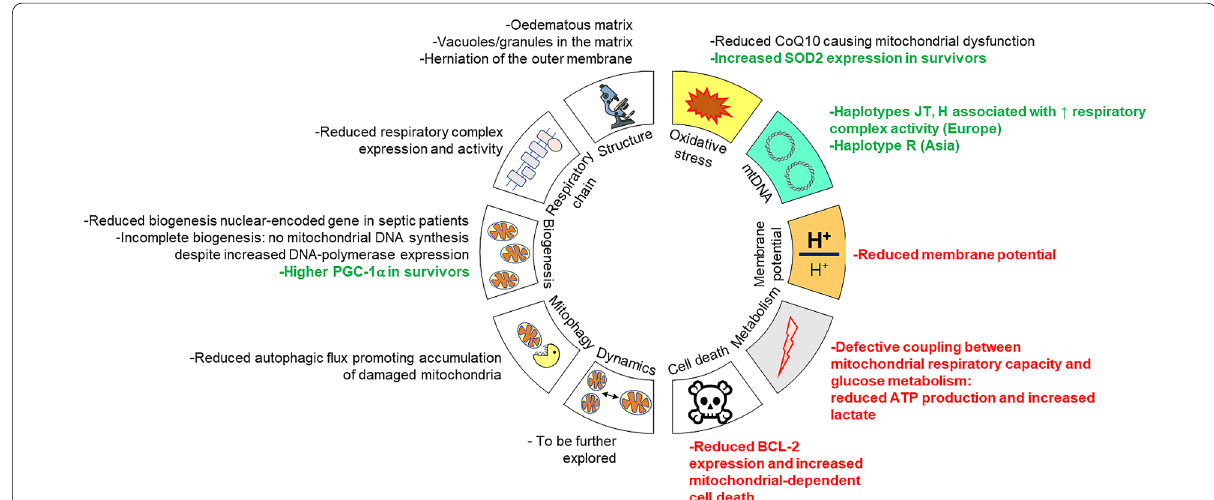
Fig. 4 Hallmarks of mitochondrial changes observed during human sepsis and septic shock. Bold red and green fonts refer to the association with increased mortality or survival, respectively. In the other cases, no correlations have been made. ATP adenosine triphosphate, BCL2 B-cell lymphoma-2, CoQ10 coenzyme Q10, DNA desoxyribonucleic acid, PGC-1α PPAR-γ coactivator-1α, SOD2 superoxide dismutase